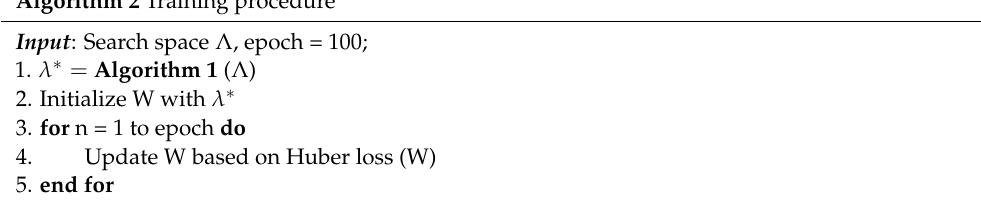
Algorithm 2 Training procedure